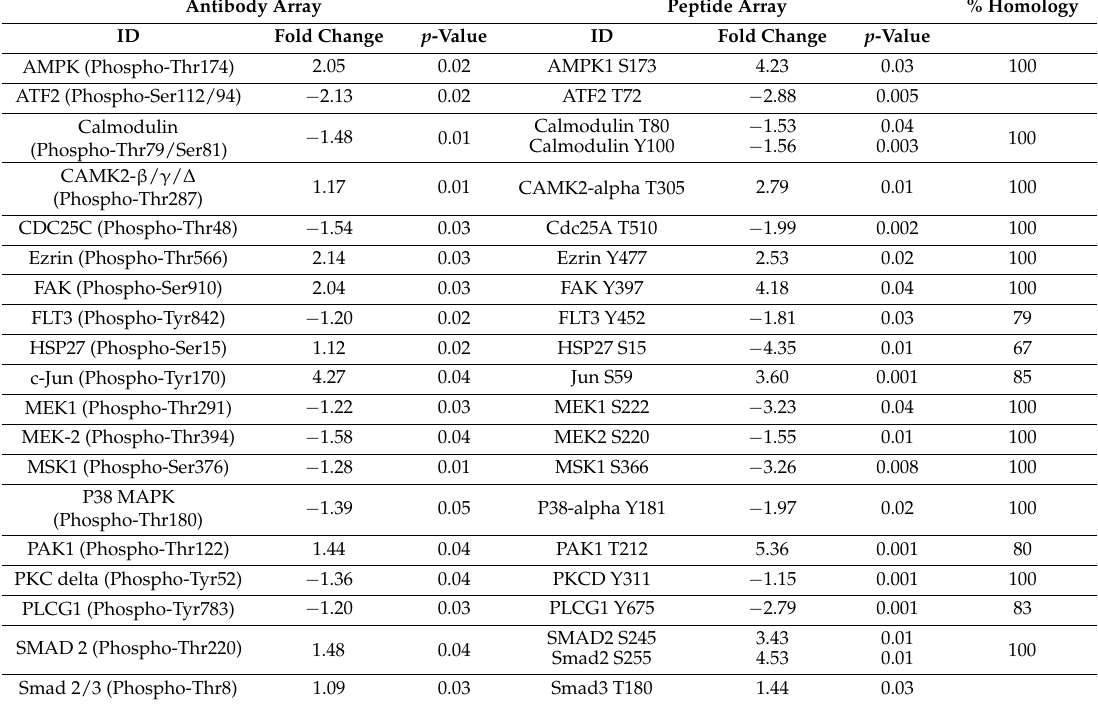
Table 6. Antibody array